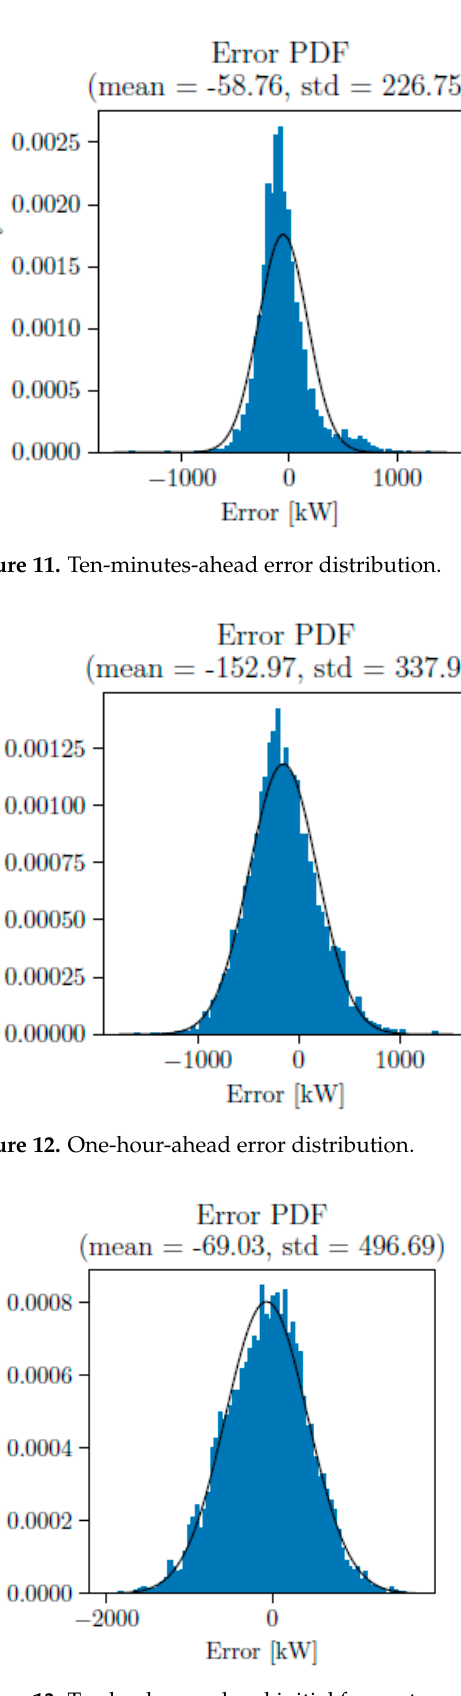
Figure 13. Twelve-hours-ahead initial forecasts.